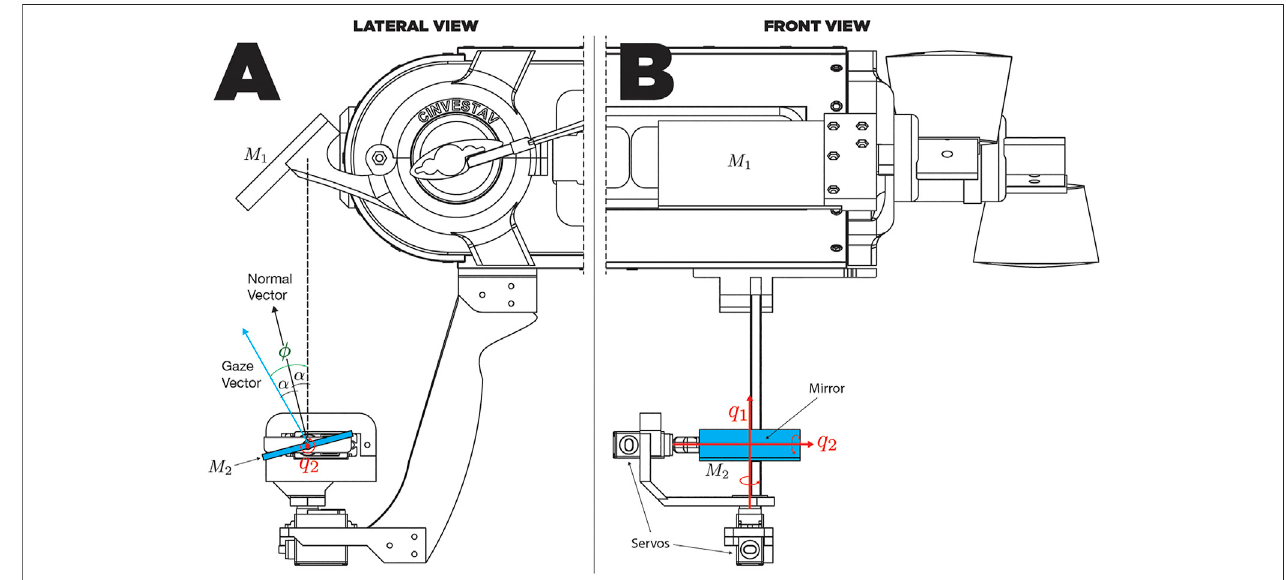
FIGURE 5 | Lateral (A) and frontal (B) view schemes of the mirror system.